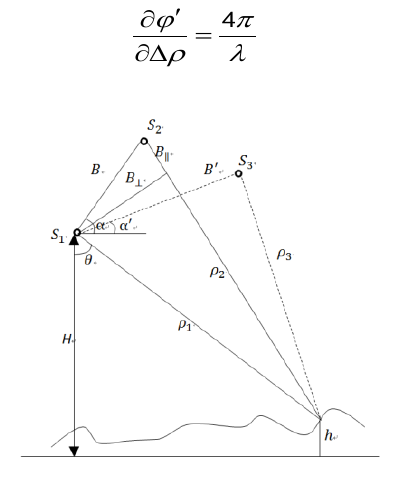
Fig.1 The basic principle of DInSAR